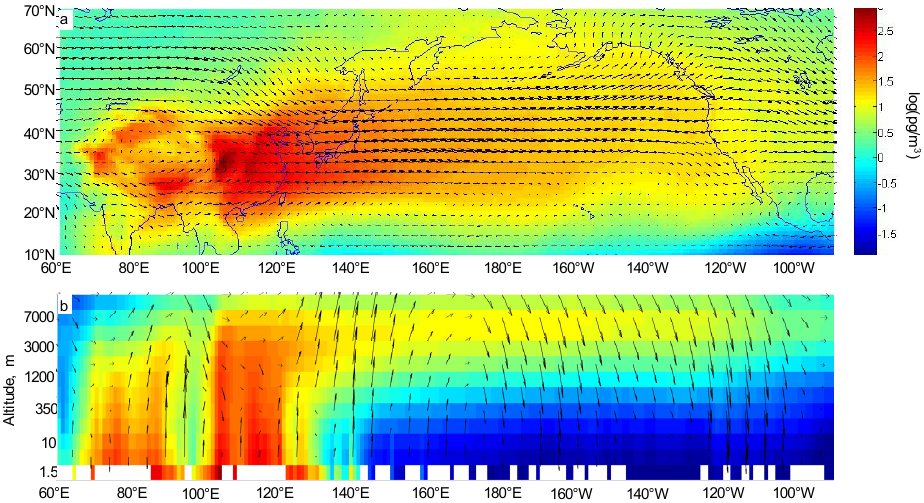
Fig. 2. Annual mean total BaP concentration (pgm − 3 ) over the northern Pacific Ocean in 2004: (a) horizontal distribution of total BaP Figure 2 Annual mean total BaP concentration (pg/m 3 ) over the northern Pacific Ocean in 2004: concentration at 3km above ground; (b) a cross section showing the meridional mean concentration between 25–55 ◦ N. a) horizontal distribution of total BaP concentration at 3 km above ground; b) a cross section showing the meridional mean concentration between 25 ‐ 55°N. averaged over 25–55 ◦ N is also shown in Fig. 2b.